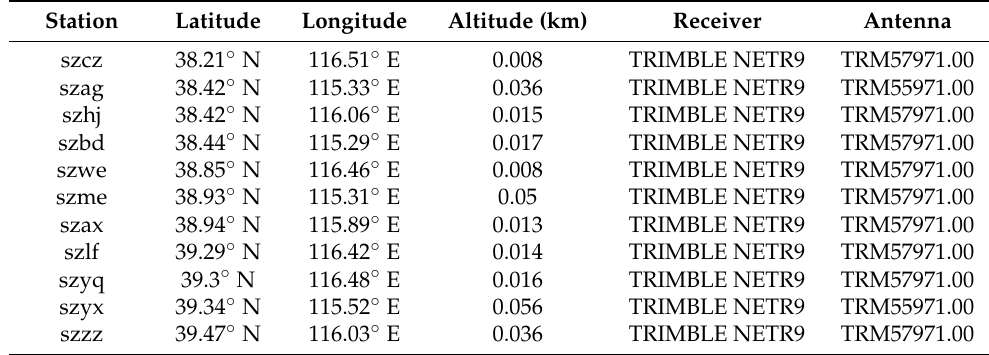
Table 1. The parameters of the